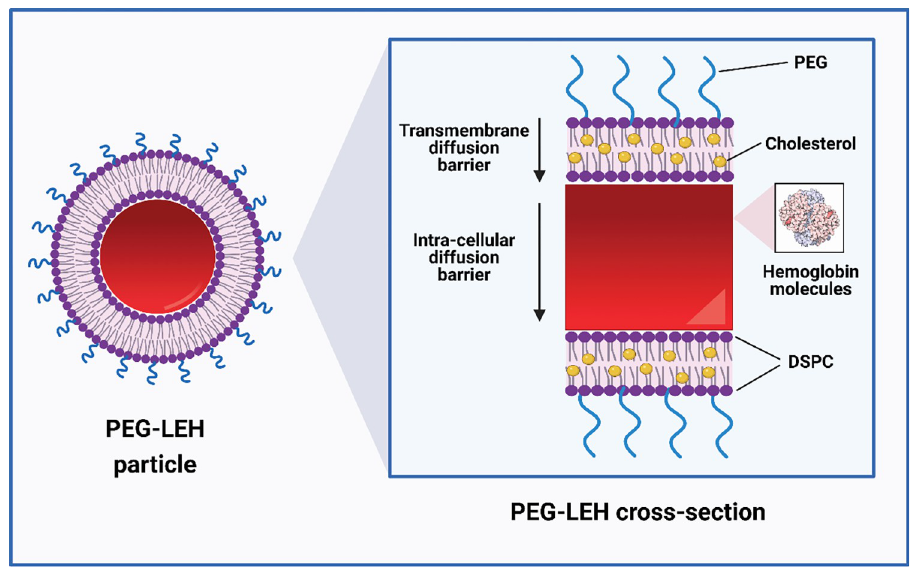
Fig 1. Structure of PEG-LEH nanoparticle. Inset: cross-section of a PEG-LEH nanoparticle with a more detailed breakdown of the structure and potential gaseous diffusion barriers [104]. Figure created with BioRender.com.